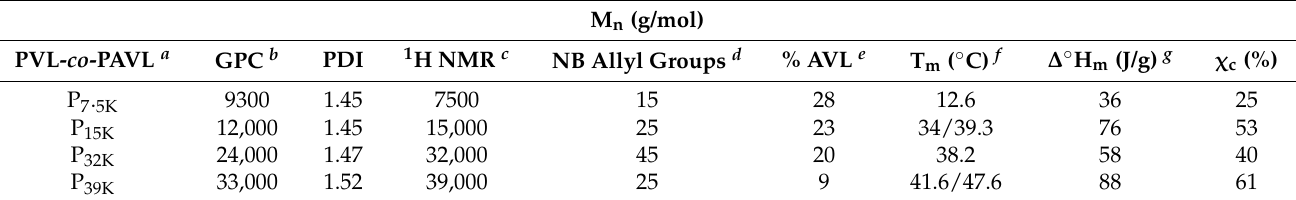
Table 1. Characteristics of the PVL- co -PAVL copolymers as studied by Le Devedec et al. Adapted with permission from [60]; published by American Chemical Society, 2018. M n